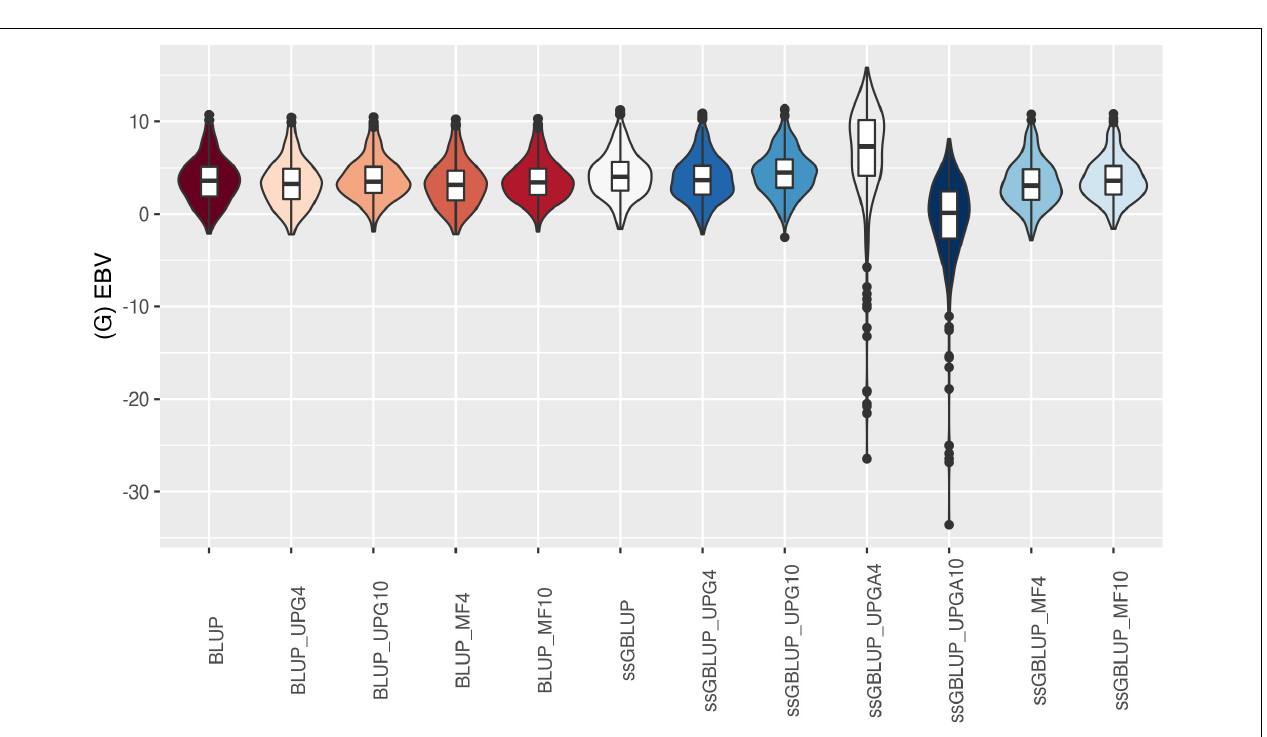
Frontiers in Genetics |